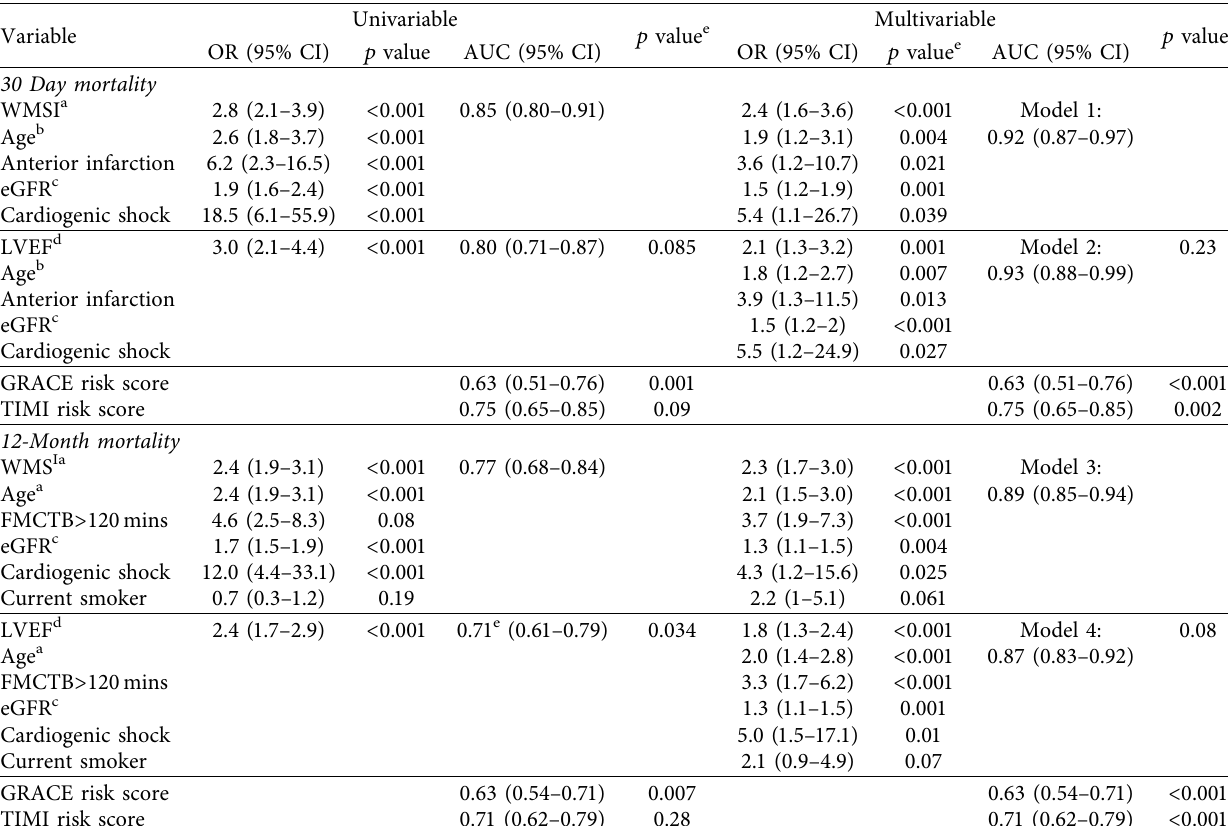
Table 2: Univariable and multivariable associations with all-cause 30-day and 12-month mortality following acute ST-segment elevation myocardial infarction (STEMI) treated with primary percutaneous intervention (PCI) ( N � 1181).